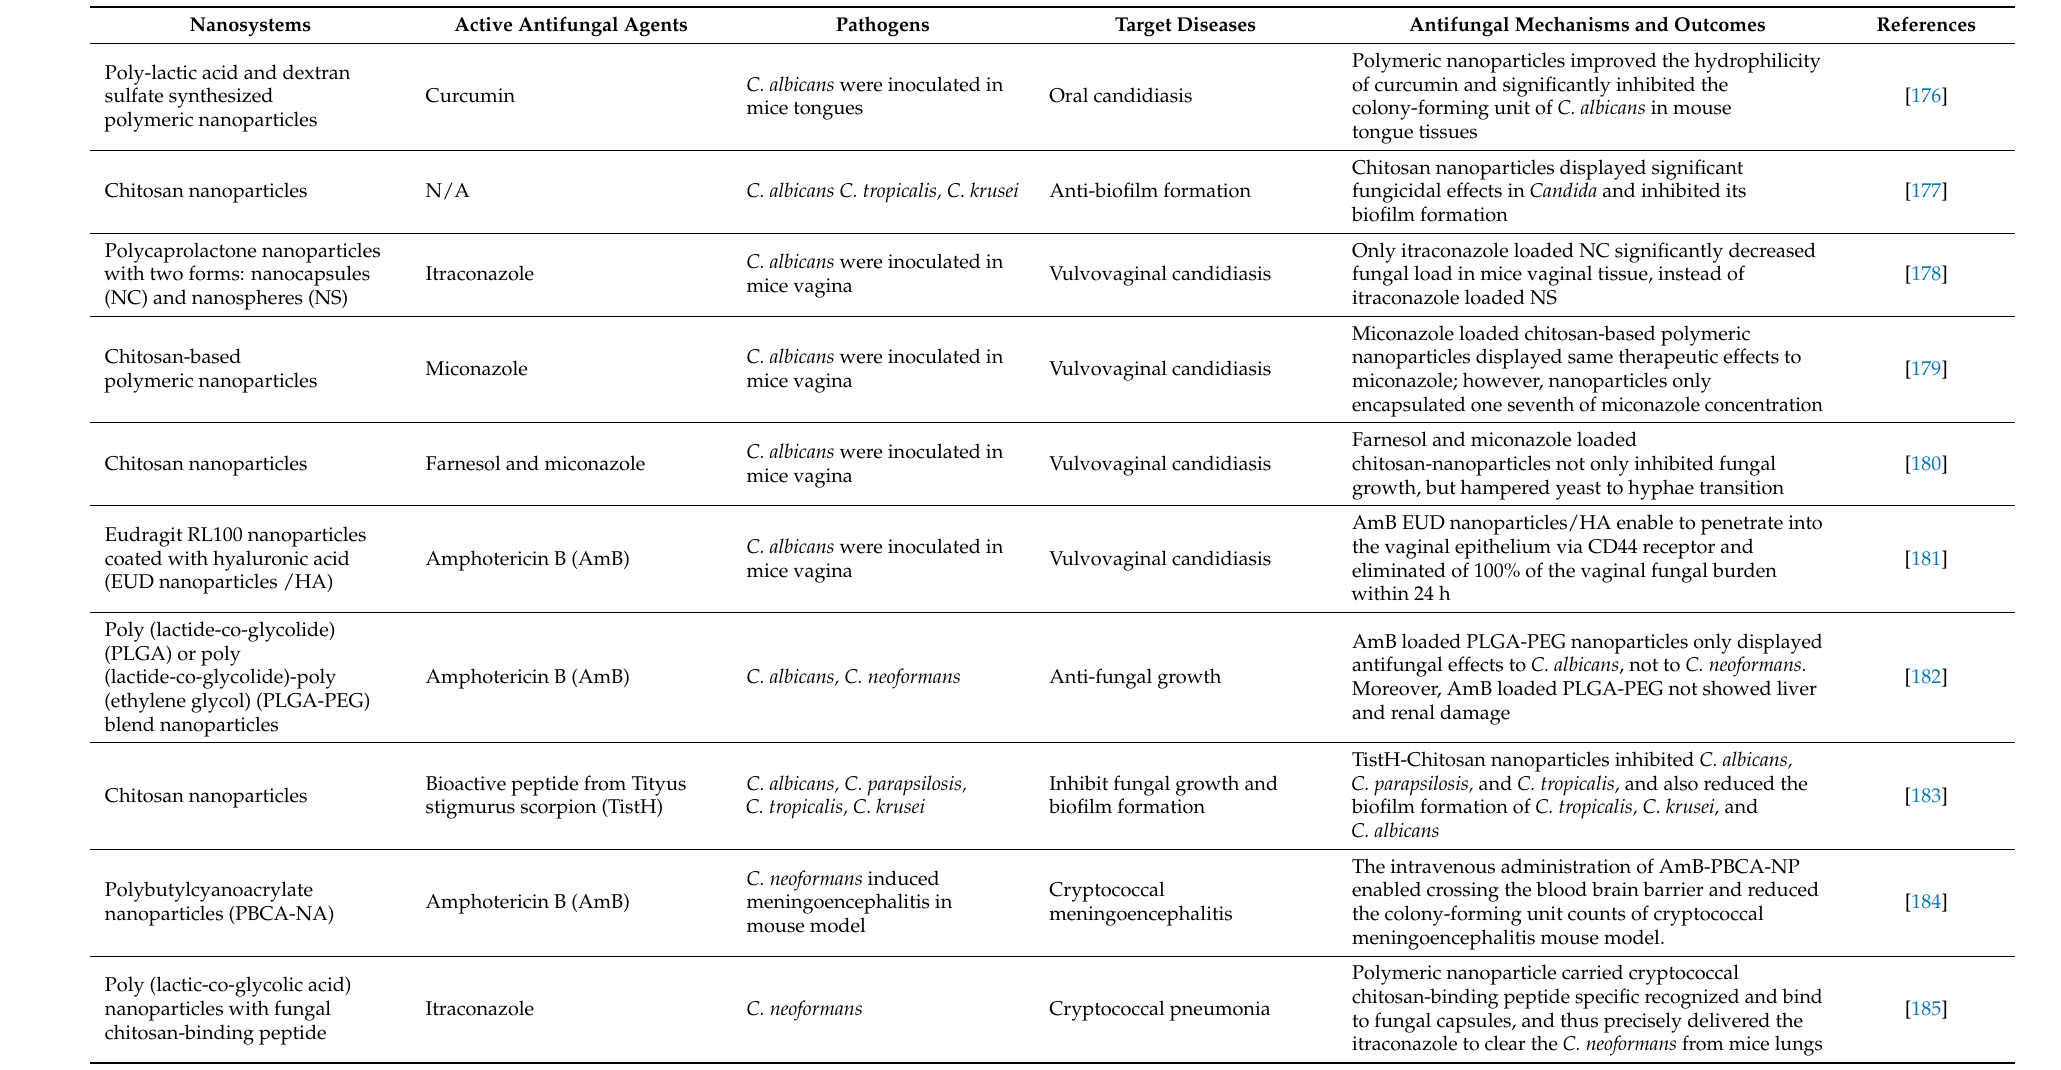
Table 5. Polymeric Nanoparticle based antifungal therapeutic